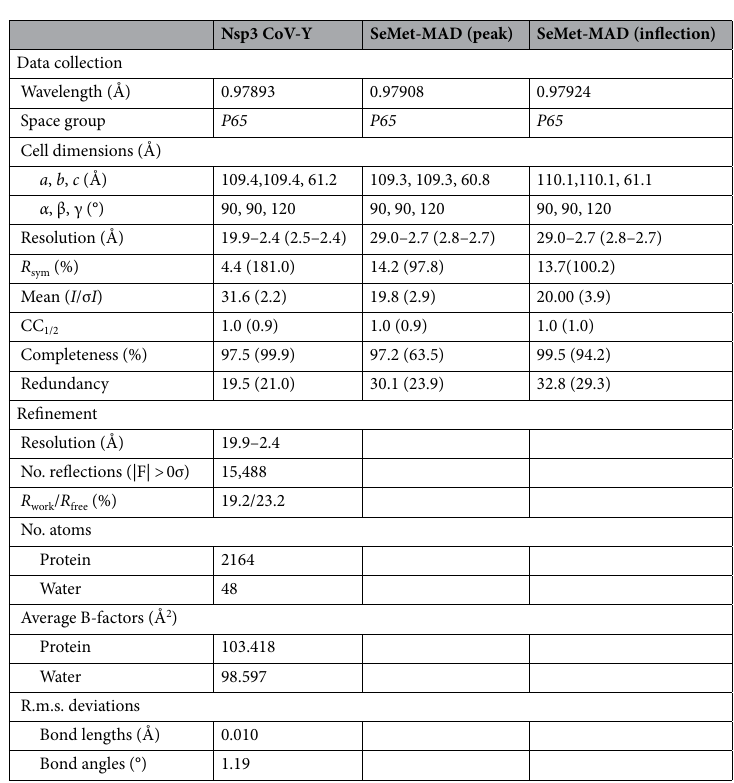
Table 1. Summary of crystallographic analysis. Values in parentheses are for the highest-resolution shell. MAD multiple wavelength anomalous dispersion.